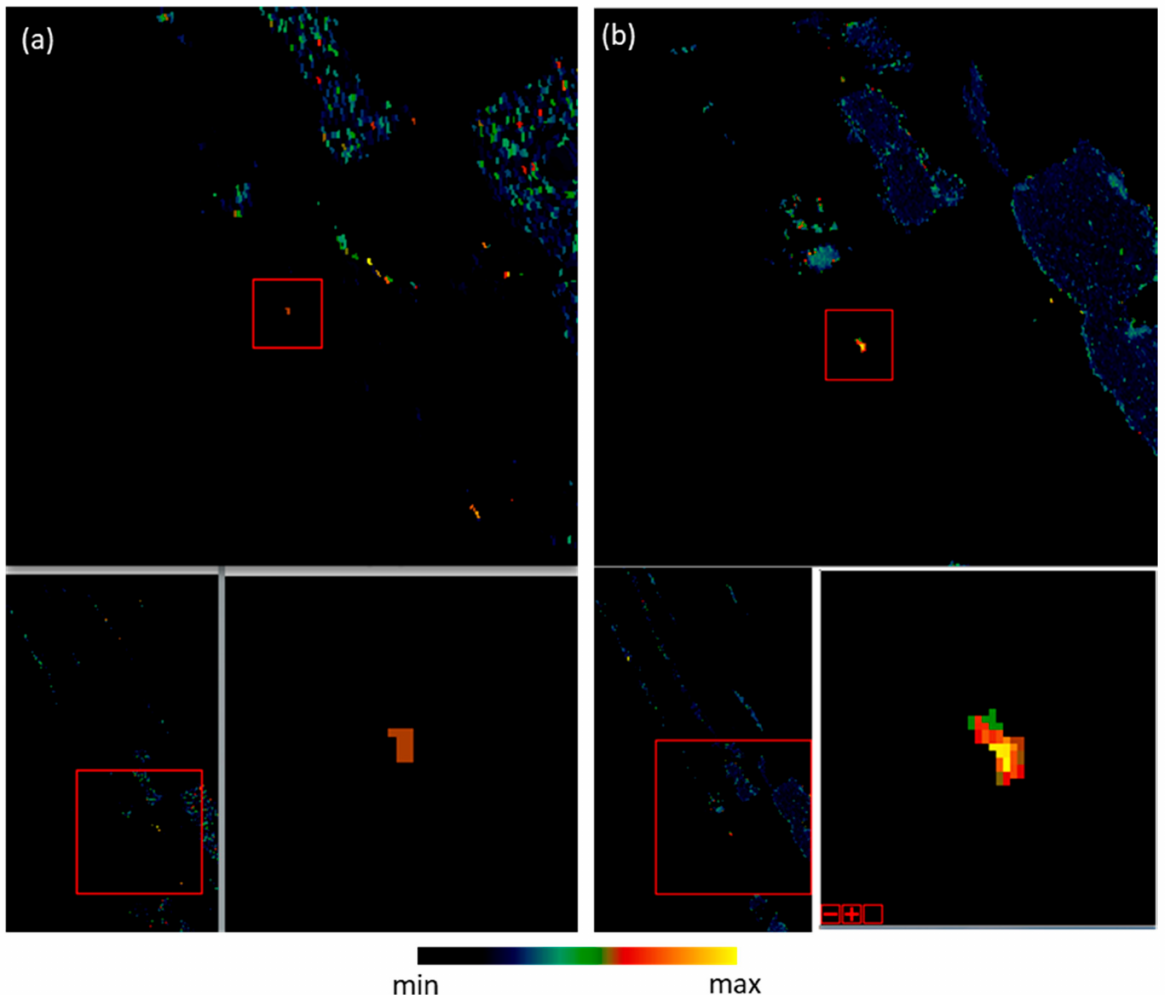
Figure 18. ( a ) Anomaly detection scores using LRX (Bottom left, the entire image; top, the area in the red square; bottom right, a zoom in on the tar pit area); ( b ) Anomaly detection scores using CRX (bottom left, the whole image; top, the area in the red square; bottom right, a zoom in on the tar pit area)